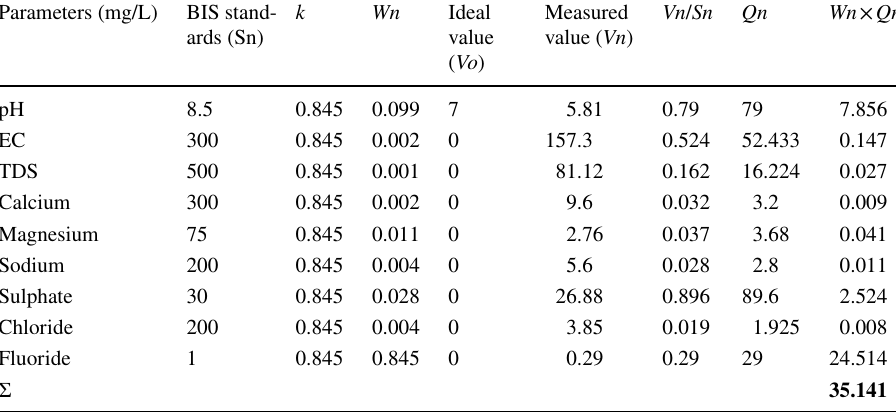
Table 2 Estimation